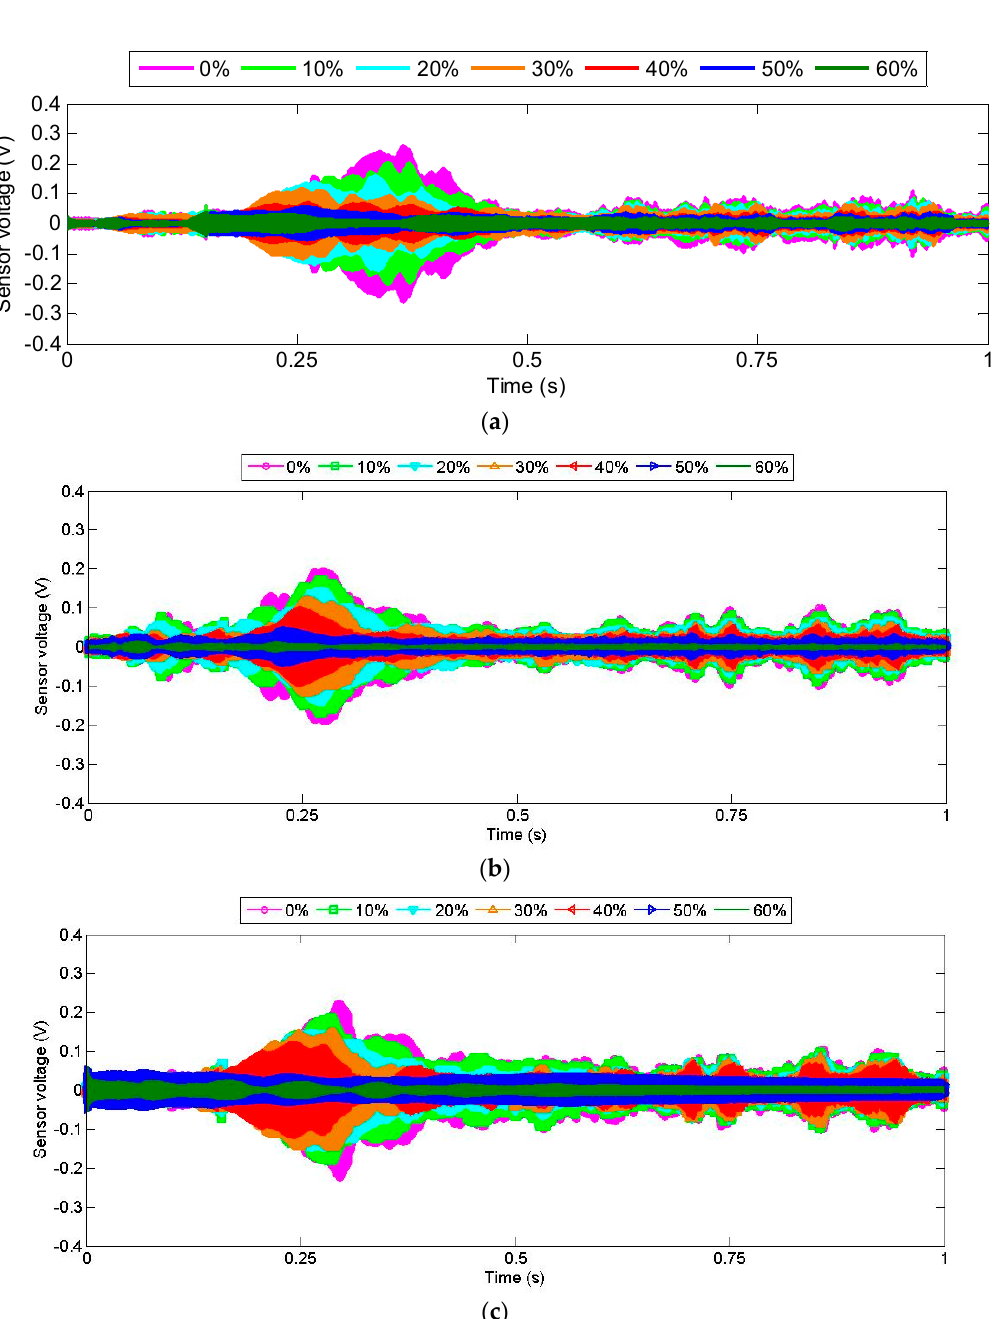
Figure 5. Sensor signal response for timber specimens. ( a ) Specimen 1; ( b ) specimen 2; ( c ) specimen 3.